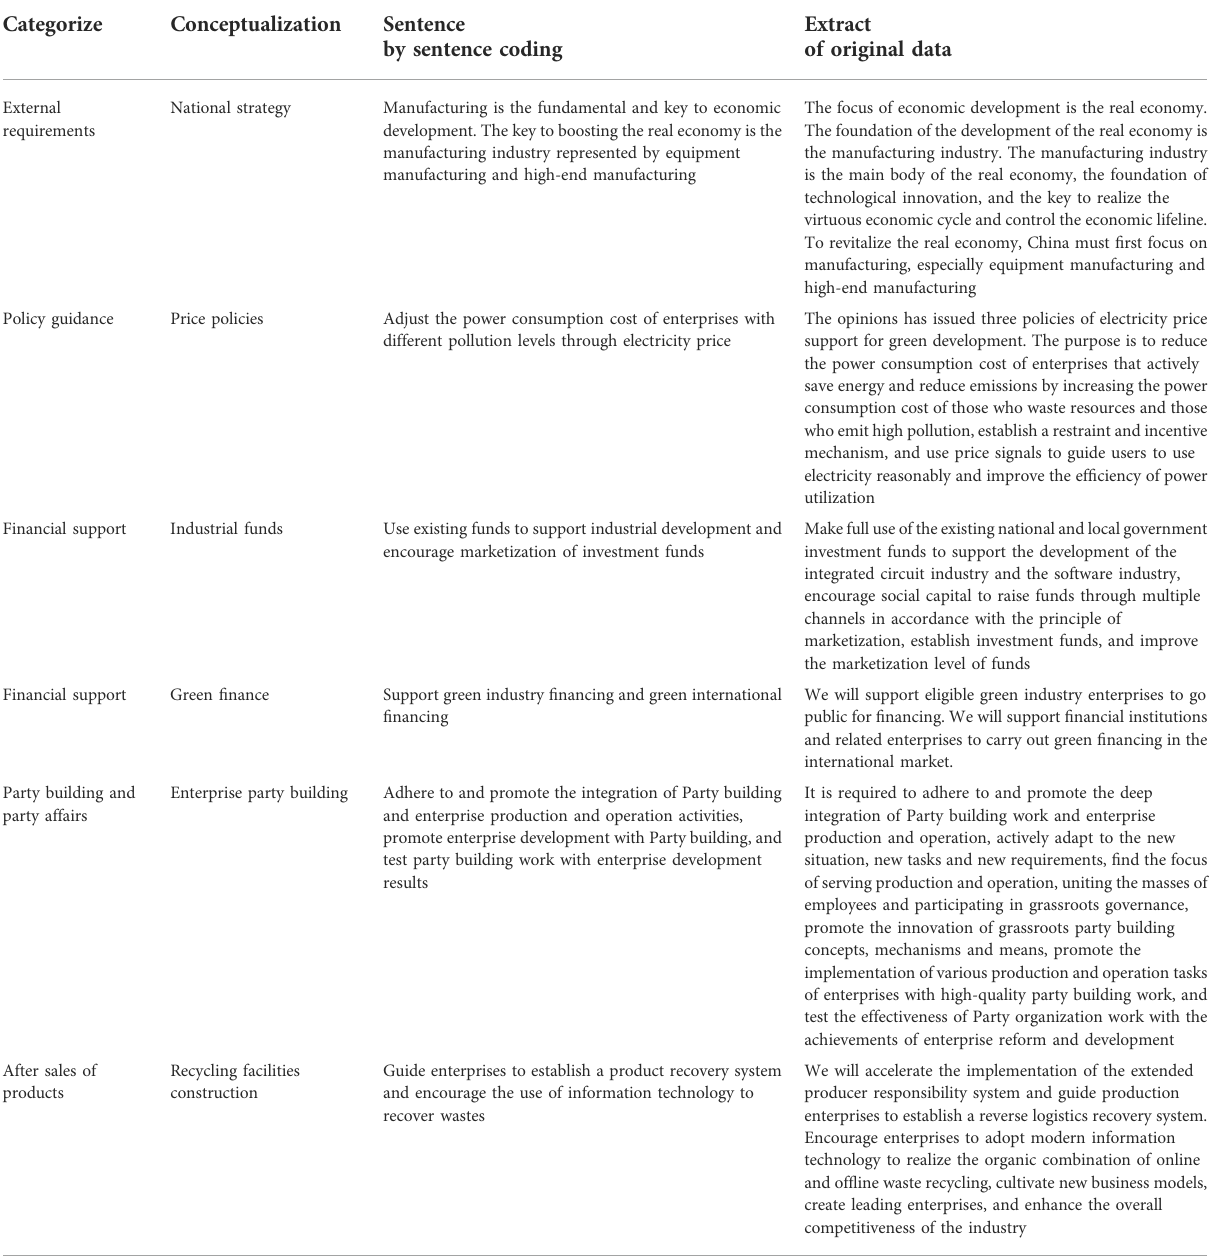
TABLE 3 Categorization of open coding